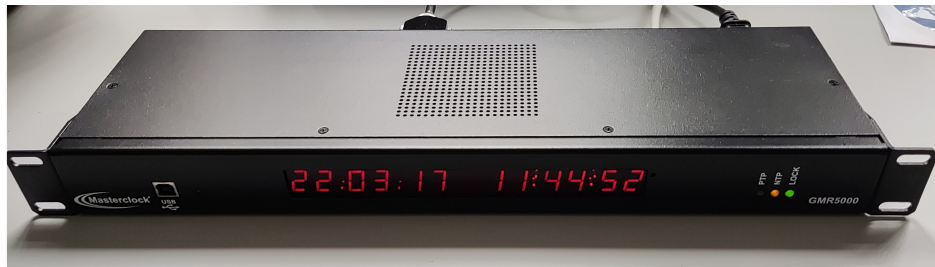
Figure 6. GMR5000 (from Masterclock Inc., St Charles, MO, USA) as an NTP local server used for time